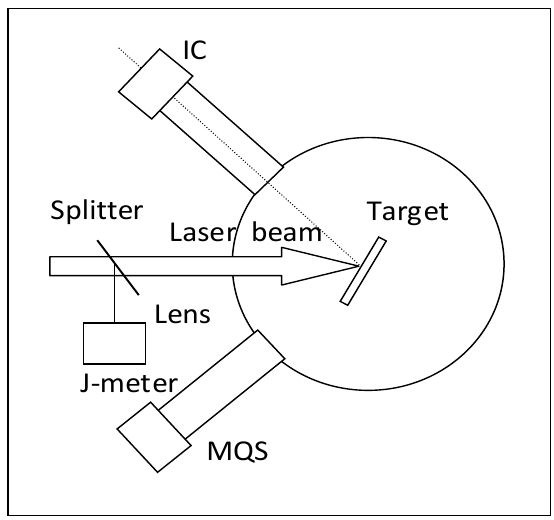
Fig. 2. Experimental set-up.